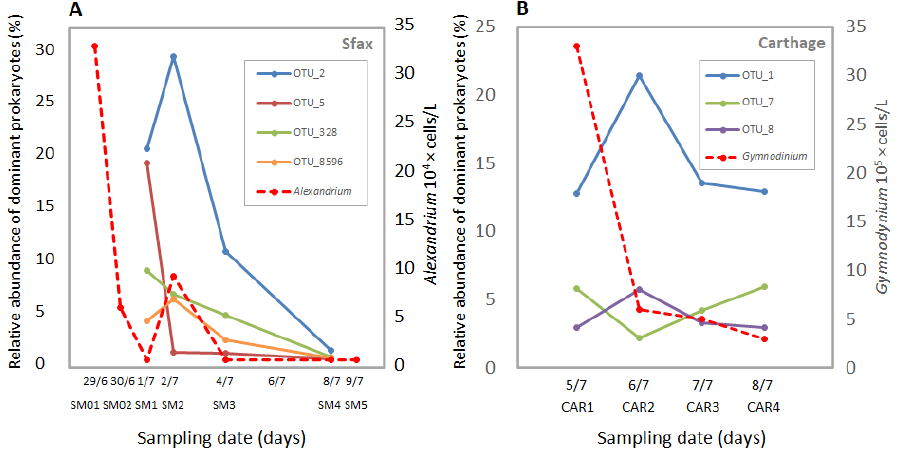
Figure 6. Relative abundances of the dominant prokaryotic OTUs (>5% of total sequences in at least one sample) associated with the abundance of A. minutum at the Sfax site ( A ) and G. impudicum at the Carthage site ( B ) during the decline phases of their respective blooms occurring in the summer of 2019. The BLAST affiliations of the dominant prokaryotic OTUs can be found in Table S2. At Carthage, the dominant prokaryotes associated with G. impudicum decay were mostly represented by Candidatus Pelagibacter (OTU #1, SAR11 subclade Ia, >99% identity) that displayed variations during the monitoring period with an increase directly correlated to the dinoflagellate decrease between CAR1 and CAR2, followed by decline. On the contrary, we observed that Ca. Thalassoarchaea (OTU #7, Euryarchaea MGIIb, ~90% identity) increased at the end of the monitoring between CAR2 and CAR4. At Sfax, the prokaryotic communities associated with A. minutum decay were dominated by two main OTUs affiliated with Rhodovulum adriaticum (OTU #5, >99% identity) and the Halochromatium / Thiohalocapsa genera (OTU #2, ~96% identity) (Figure 6 and Table S2). Rhodovulum OTU #5 dramatically decreased between SM1 and SM2, while Chromatiaceae OTU #2 increased during the same period before decreasing at the end of the monitoring, corresponding to the disappearance of the red color of the waters. A PCA was performed to identify the factors that affected the prokaryotic communities during the dinoflagellate decays (Figure 7). The first two principal components explained 87.9% and 84.2% of the variability in the data from Sfax and Carthage, respectively. A Spearman’s rank correlation analysis showed positive correlations between the dominant prokaryotes, A. minutum , and PO 43 − at Sfax, while no relationship was observed between G. impudicum and the dominant prokaryotic OTUs at Carthage, where they were influenced by the DIN concentrations.